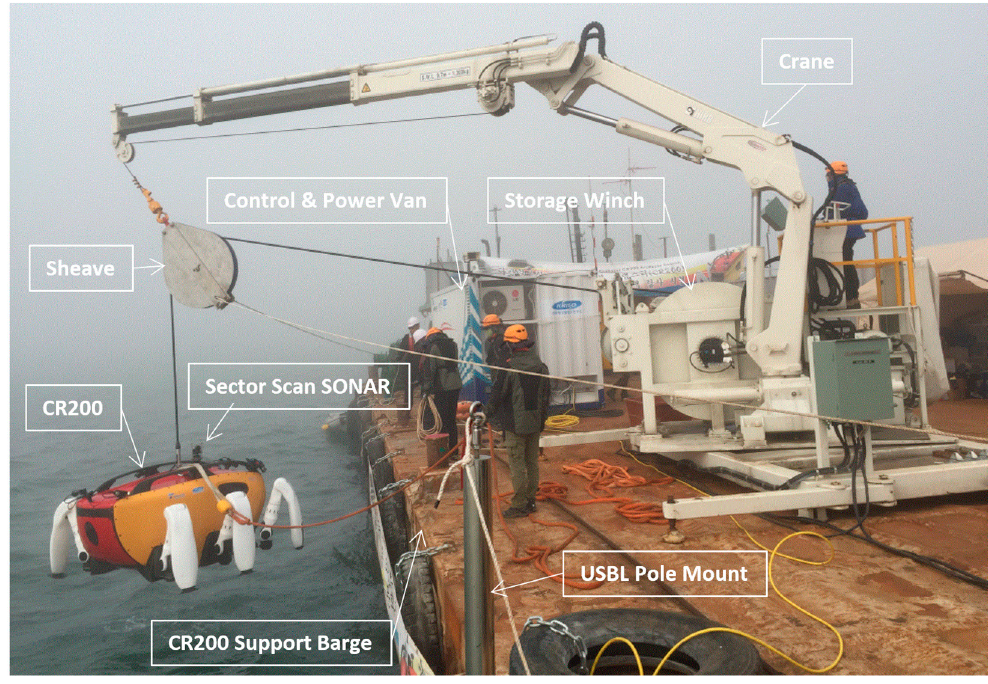
Figure 14. CR200 system on the barge. Sensors 2020 , 19 , x FOR PEER REVIEW